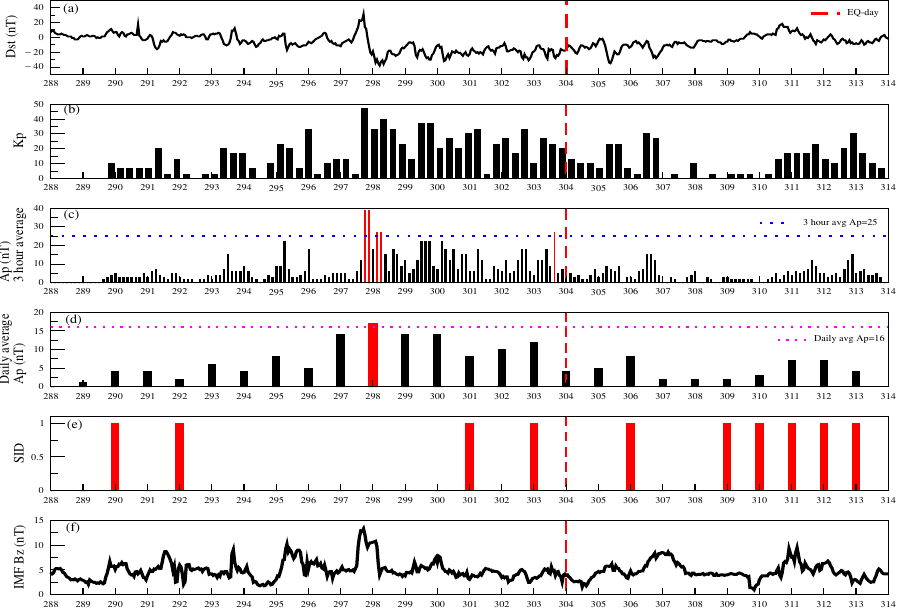
Figure 2. Daily variation of ( a ) Dst; ( b ) Kp; ( c ) 3-hour average Ap; ( d ) daily average Ap; ( e ) SID; ( f ) IMF-Bz from the day of the year 288 to 314. Solar active days are shown by a red bar, whereas solar quiet days are indicated by a black bar (for ( c – e )). The dashed red line denotes the EQ day. The blue dashed line represents the three-hour average A p value of 25, and the magenta dashed line represents the daily average A p value of